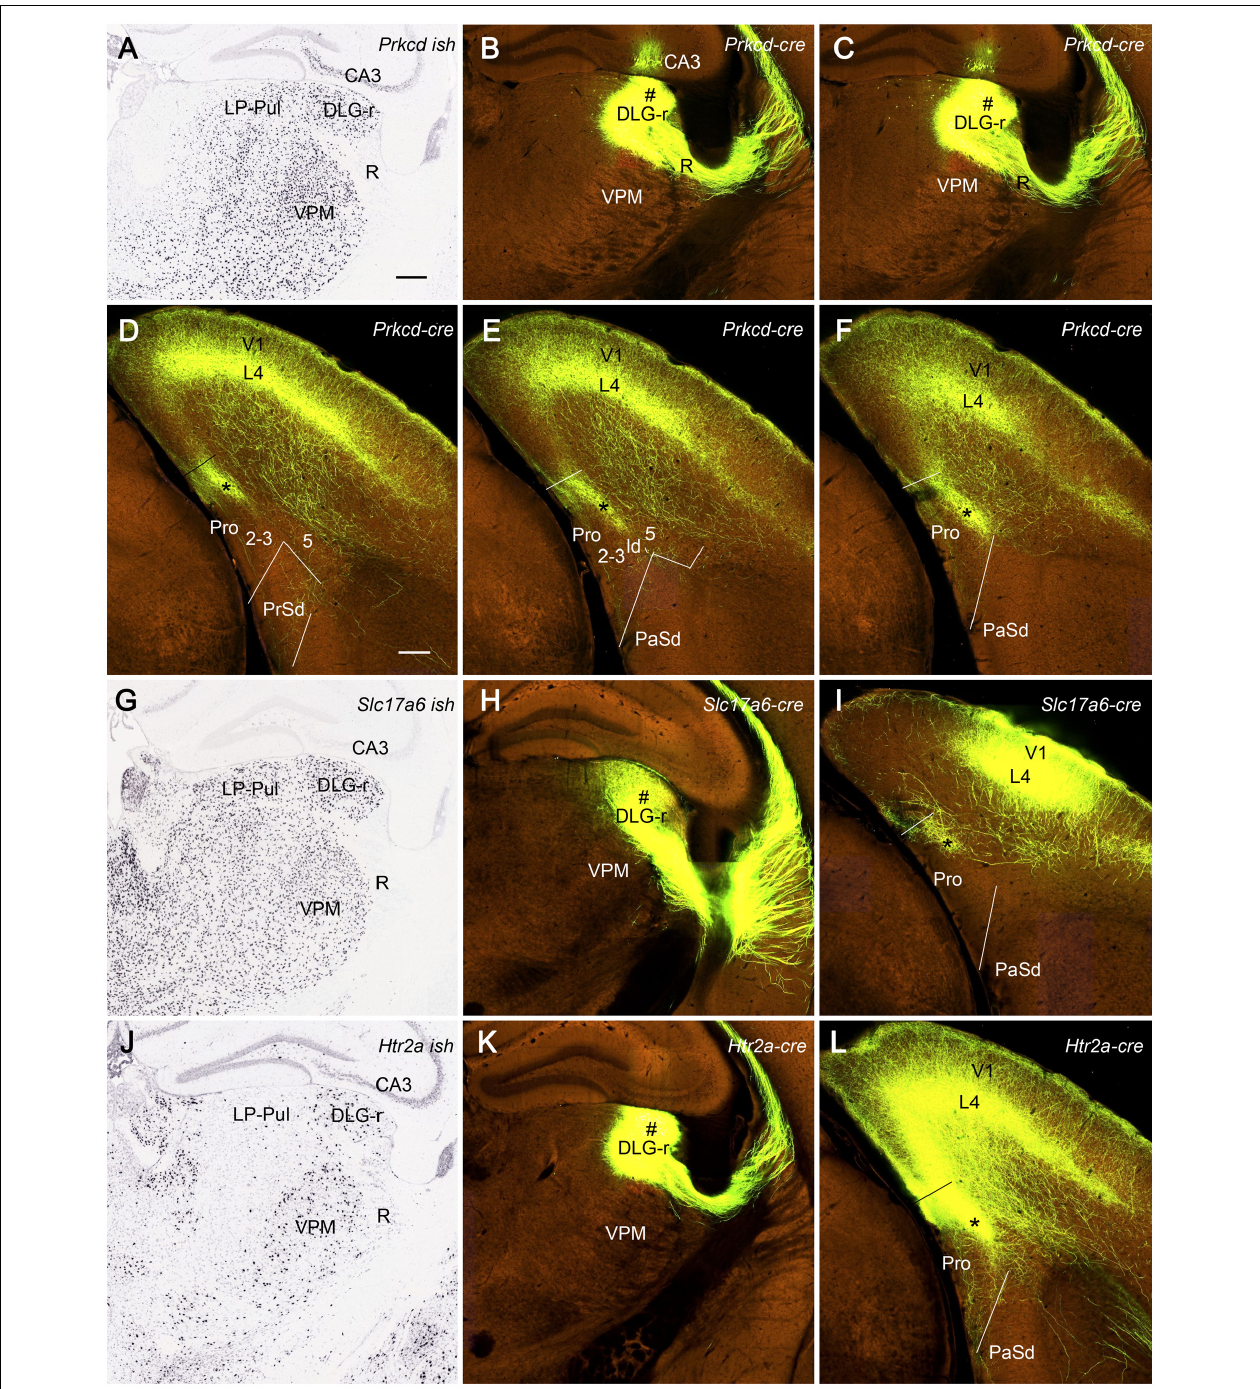
FIGURE 12 | Efferent projections from DLG to prostriata in mouse. All panels are from coronal sections. (A) Expression of Prkcd -Cre in the thalamus of a Cre-line mouse. (B,C) One anterograde viral tracer injection (#) is involved in the DLG-r as well as a small portion of LP-Pul and ventral posteromedial thalamic nucleus (VPM) of a Prkcd -Cre mouse. (D–F) Strongly labeled axon terminals are detected in layer 3 and lamina dissecans (marked by the stars) of the dorsal prostriata as well as in layer 4 and deep layer 3 of V1 as shown on sequential coronal sections from rostral (D) to caudal (F) levels. (G) Slc17a6 -Cre expression in the thalamus. (H,I) Another injection mainly located in the intermediate part of DLG with partial involvement in the DLG-r (# in H ) of a Slc17a6 -Cre mouse produces terminal labeling in the dorsal prostriata only at the caudal level (indicated by the star in I ). (J) Htr2a -Cre expression in the DLG-r of the thalamus with much less expression in nearby region. (K,L) The third injection (#) mainly involved in the DLG-r (K) of a Htr2a -Cre mouse results in strongly labeled axon terminals in layer 4 and deep layer 3 of V1, as well as in layer 3 and lamina dissecans (indicated by the star in L ) of the dorsal prostriata along rostro-caudal levels ( L showing only the caudal level image). Bars: 285 µ m (A) for (A–C,G,H,J,K) ; 200 µ m (D) for (D–F,I,L)